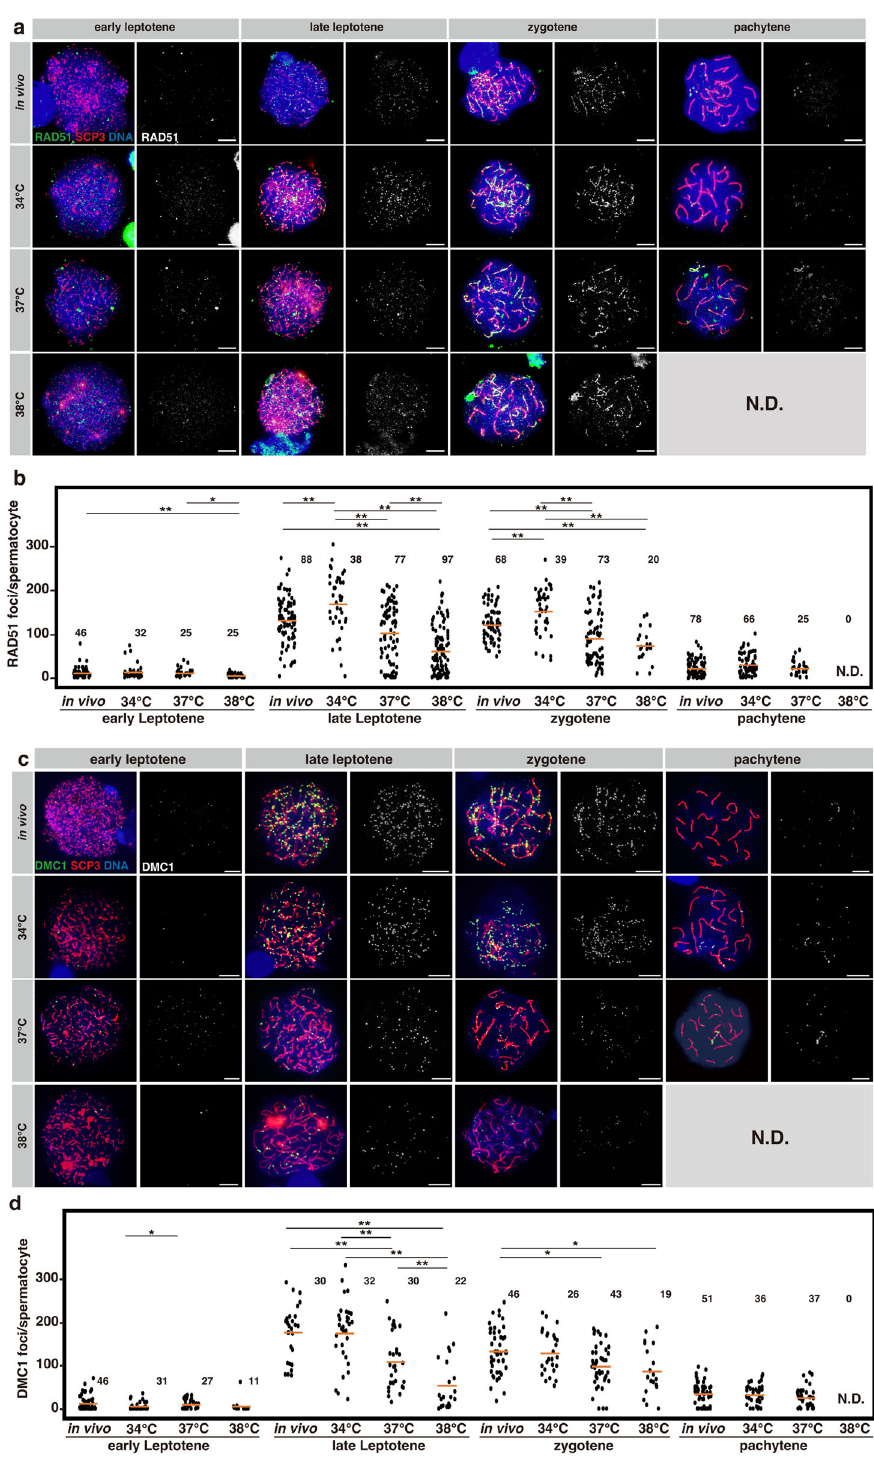
Fig. 6 Evaluation of repair foci formation at different temperatures. a , c Representative images of chromosomal spreads in meiotic prophase I substages, prepared from the testes of 5-week-old Acr-GFP mice and testis explants cultured for 5 weeks at 34, 37, or 38 °C. Samples were stained for RAD51 ( a ), and DMC1 ( c ) shown in green, with SCP3 (red) used for staging and DNA (blue). RAD51 and DMC1 signals are shown separately in the right panels. Scale bars, 10 μ m. b , d Dot plots showing the number of RAD51 ( b ), and DMC1 ( d ) foci associated with SCP3 + chromosome axes in each spermatocyte of the indicated substage prepared from the in vivo and ex vivo testis samples. Each dot represents an individual spermatocyte with means indicated as horizontal bars. The number of spermatocytes analyzed are indicated above the plots (N.D. not detected). Cells prepared from three, four, and two testes from different individuals (in vivo ) and 14 and 4 (34 °C), 15 and 10 (37 °C), and 15 and 4 (38 °C) explants were pooled and analyzed in ( b , d ), respectively. Multiple comparisons were conducted using the Kruskal – Wallis test among all values within each category and gave p -values of 0.01, 4.75E-18, 1.68E-9, and 0.11 in ( b ) and 0.02, 9.08E-9, 2.20E-3, and 0.25 in ( d ), respectively, for early leptotene, late leptotene, zygotene, and pachytene. The Steel – Dwass test was applied for combinations of two values within each category resulting in the p -values as indicated in the plots (* p < 0.05, ** p <